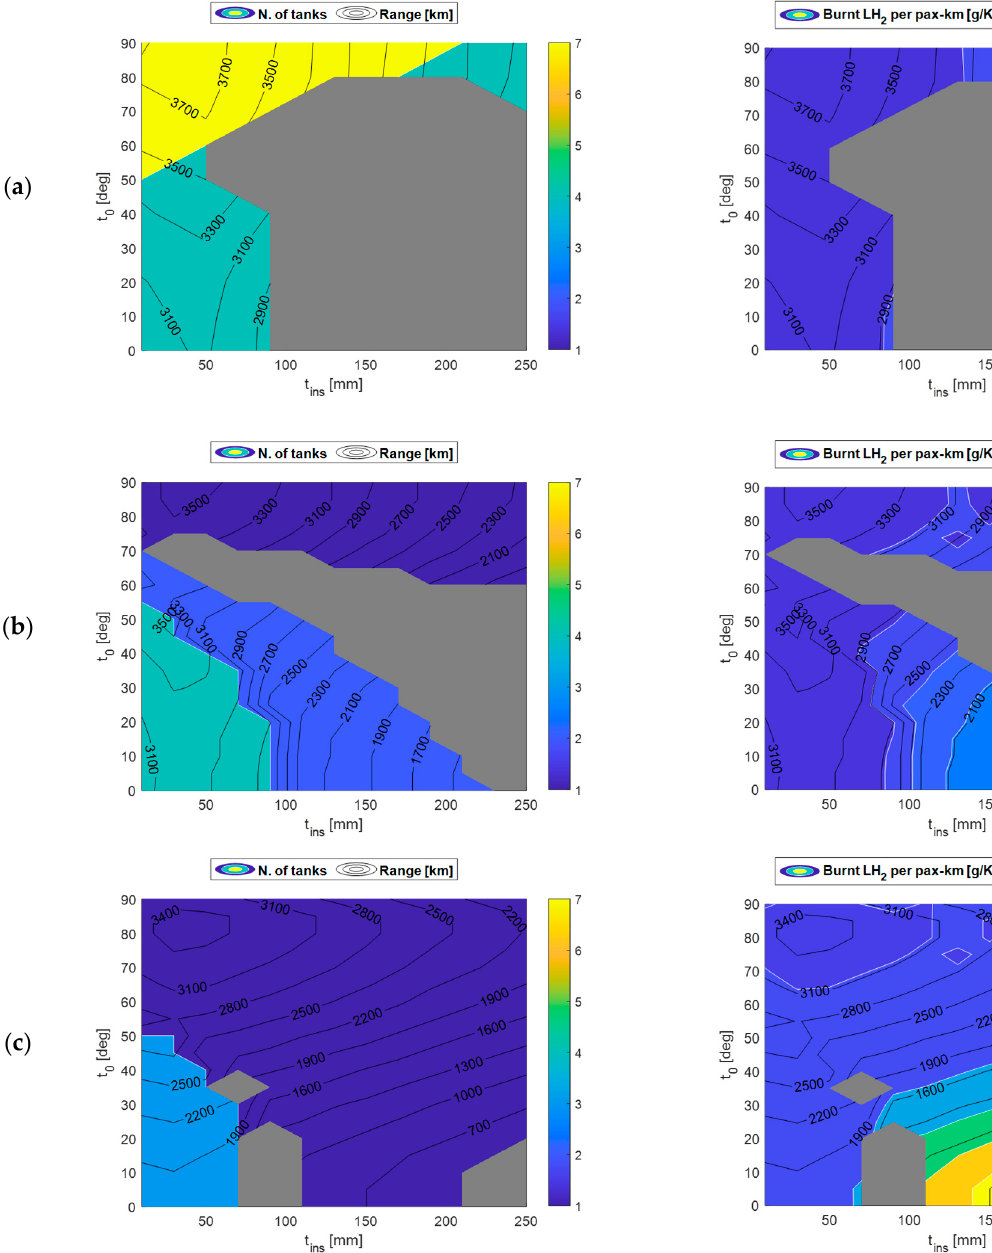
33 of 44 Figure 18. Sensitivity to length-to-diameter ratio ( 𝐿 𝐷 (cid:3046)(cid:3047)(cid:3045) ⁄ ) and insulant thickness ( 𝑡 (cid:3036)(cid:3041)(cid:3046) ) with indica- tion of flight range: ( a ) empty mass fraction ( 𝜇 (cid:3047)(cid:3028)(cid:3041)(cid:3038) ) and ( b ) embarked LH 2 mass. Figure 18a indicates that, for an assigned value of 𝑡 (cid:3036)(cid:3041)(cid:3046) , 𝜇 (cid:3047)(cid:3028)(cid:3041)(cid:3038) reaches the lowest val- ues as 𝐿 𝐷 (cid:3046)(cid:3047)(cid:3045) ⁄